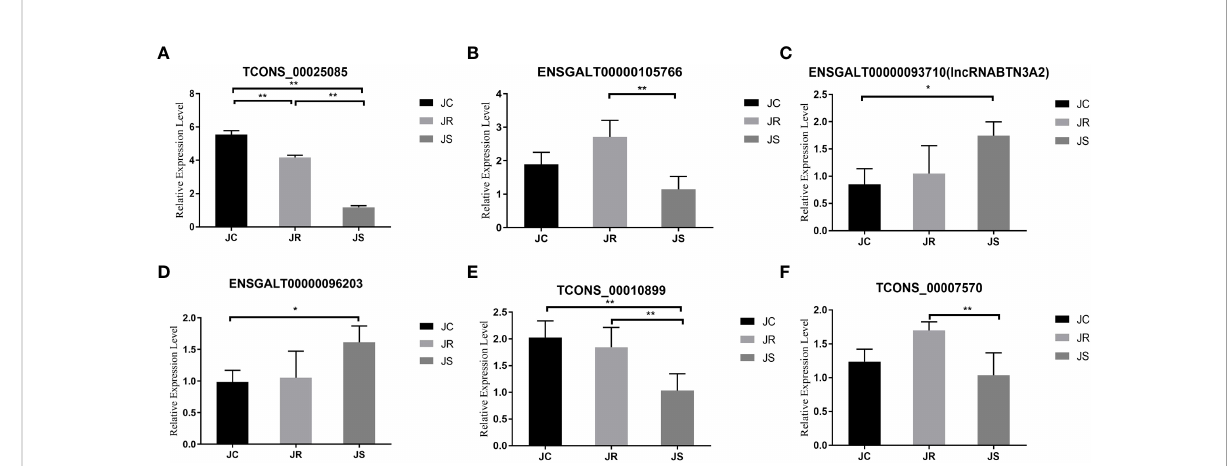
FIGURE 7 Validation of differentially expressed lncRNAs in chicken cecal tissues of different groups during E . tenella infection. The six lncRNAs were as follows: (A) TCONS_00025085, (B) ENSGALT00000105766, (C) ENSGALT00000093710 (lncRNA BTN3A2), (D) ENSGALT00000096203, (E) TCONS_00010899 and (F) TCONS_00007570. Values are the mean ± SD (n = 3 per group), and qRT – PCR analysis of three biological replicates was conducted. * P < 0.05, ** P <